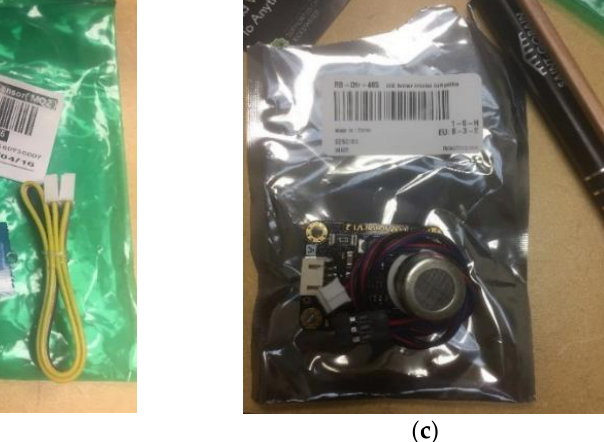
( b ) Figure 7. In the red circle the weather station installed on the roof: ( a ) weather station ( b ) weather station on the roof of the Palace.